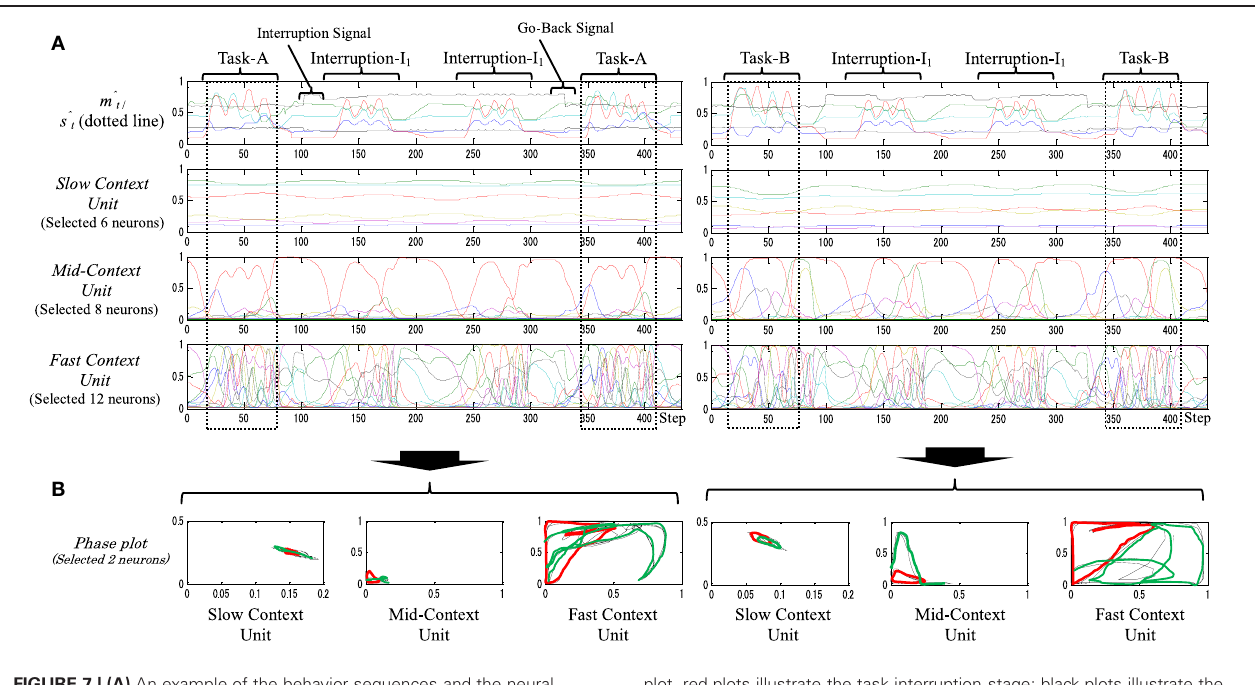
FIGURE 7 | (A) An example of the behavior sequences and the neural activities of task-A [Task-A → I 1 × 2 → Task-A (left)], and task-B [Task-B → I 1 × 2 → Task-B (right)]. (B) Their phase plots. As is apparent in the figure, both tasks were subjected to two sets of a task interruption-I 1 . In the phase